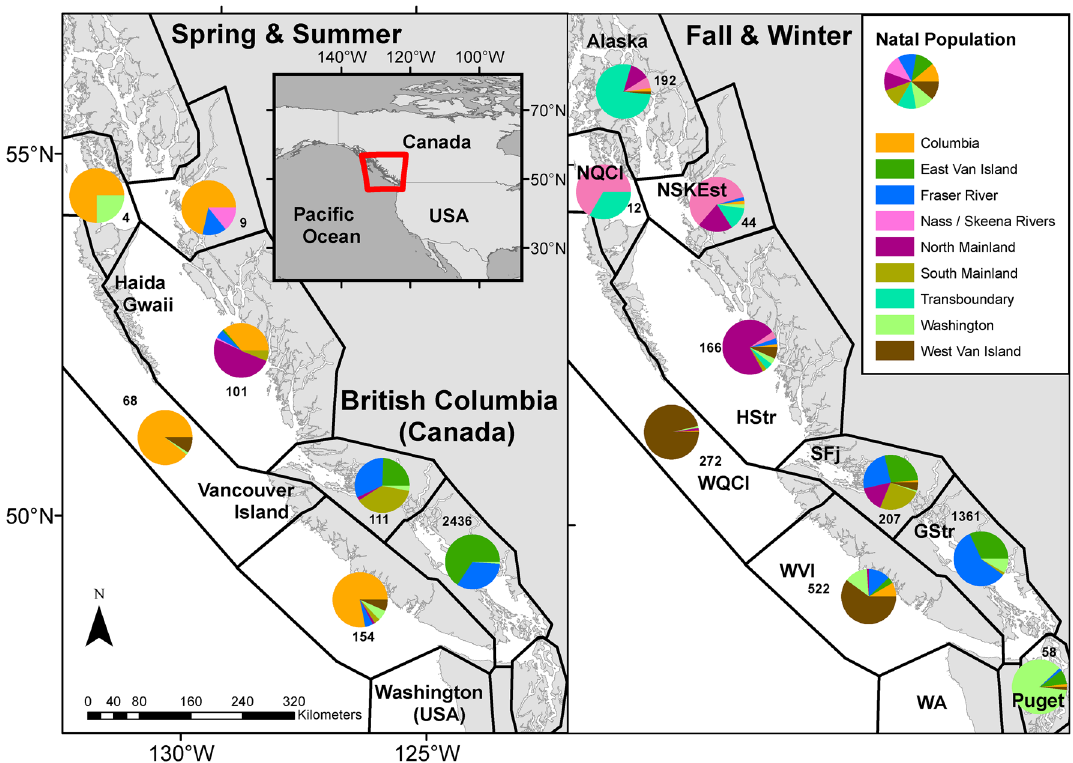
Figure 2. Regional stock compositions, as determined by genetic stock identification, for Chinook salmon collected along the British Columbia coast, 2008–2018. Red outline in inset panel indicates study area extent. Pie charts represent the proportions of stock groupings sampled from regions adapted from DFO’s Marine Adaptive Zones 39 (black borders, text in right panel). Total Chinook sampled in each zone provided. Total sampled per zone and stock percentages for all species are in Tables S1, S2, S3. Basemap data are from the GSHHG (Global Self-consistent, Hierarchical, High-resolution Geography) Database 38 . The coordinate system for the data is WGS 1984 and the maps are projected in NAD